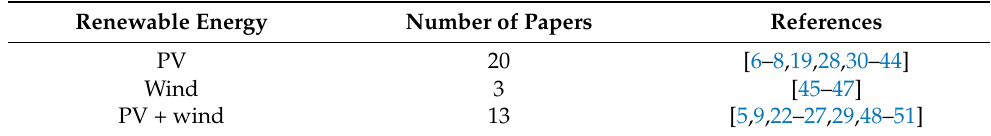
Table 3. Renewable energies related to PQ monitoring